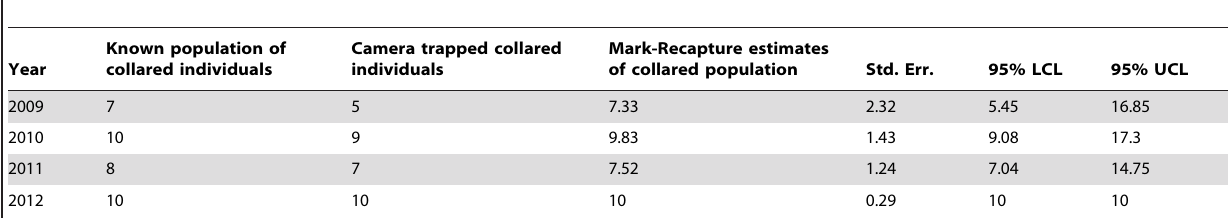
Table 3. A comparison of the known ‘population’ of radio-collared snow leopards and their population estimated using mark- recapture analysis in the Tost Mountains, South Gobi, Mongolia, between 2009 and 2012.